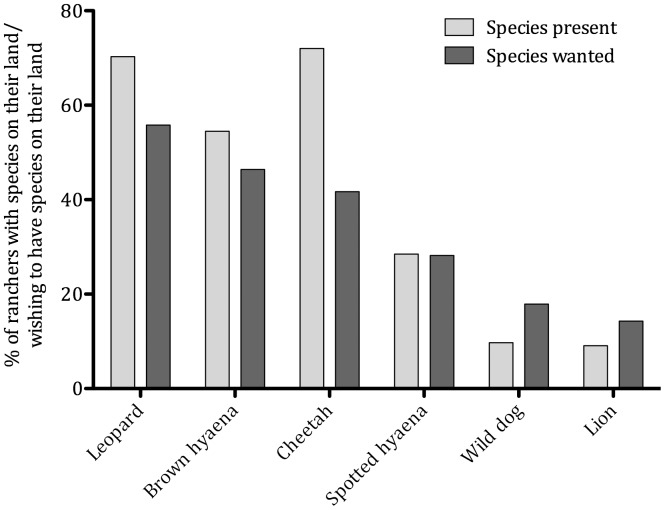
Percentage occurrence of large carnivore species on Namibian commerical farms and the percentage of farmers who wish to have those species on their properties.